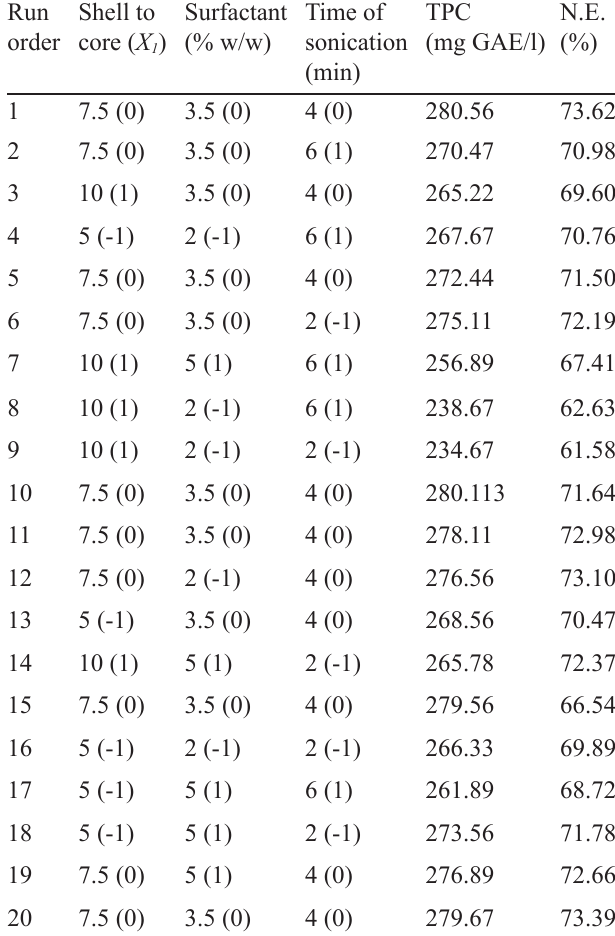
Table 2. The arrangement and responses of the three-factor, three- level second-order regression for central composite